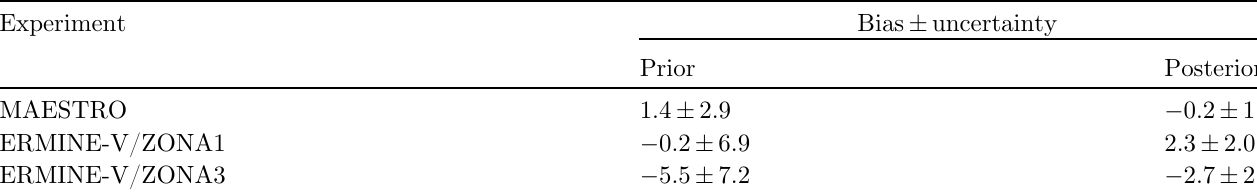
Table 7. Comparison of prior and posterior bias and uncertainties on the Rh reactivity